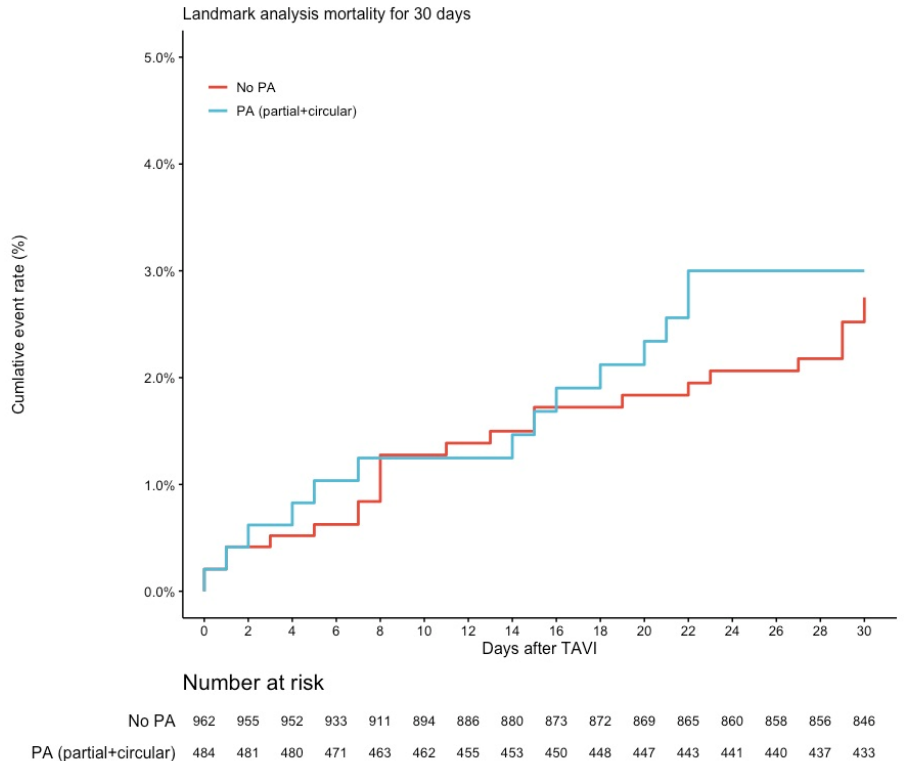
Figure 2. Kaplan–Meier Curve for mortality up to 30 days. Abbreviation: PA, porcelain aorta. 1 Lost to follow-up at 30 days: n = 30 (2.0%).